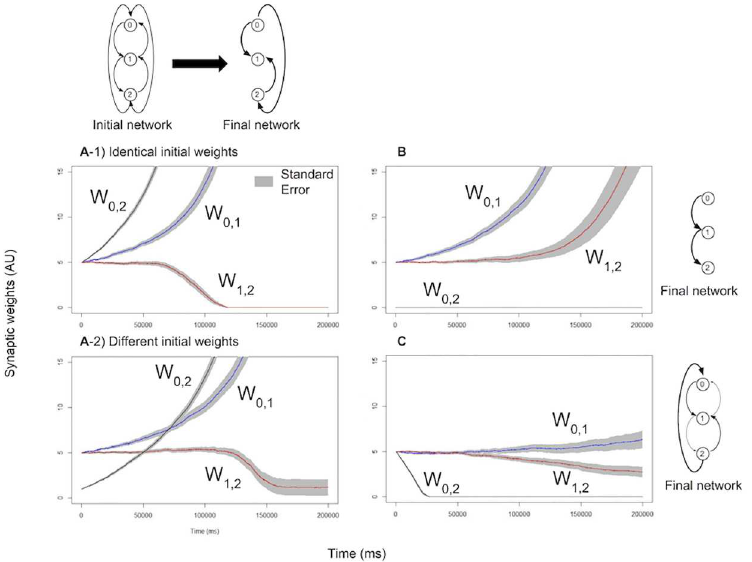
Fig 4. Dynamicsof weight changes induced by LSA in small networks of 3 neurons. A) Reinforcement: spikingof neuron2 stops the stimulationin neuron0. The direct weight w 0,2 grows faster than other weights, even when starting at a lower value. B) Artificially fixing the direct weight w 0,2 to 0, a longerpathway of 2 connections 0 ! 1 ! 2 is established. C) Pruning:spikingof neuron2 starts external stimulationto neuron0. As a result, w 0,2 is